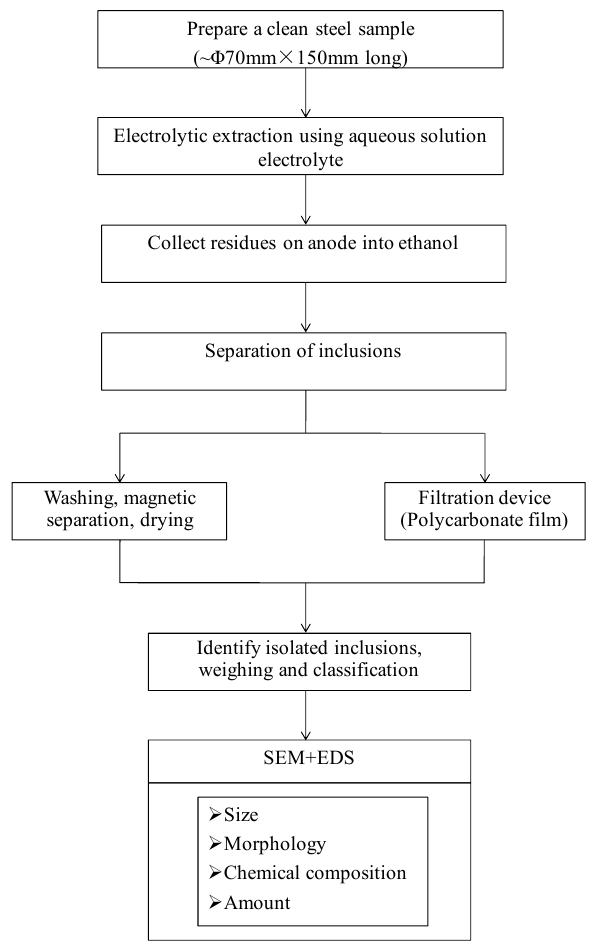
Figure 1. Large sample electrolysis process.